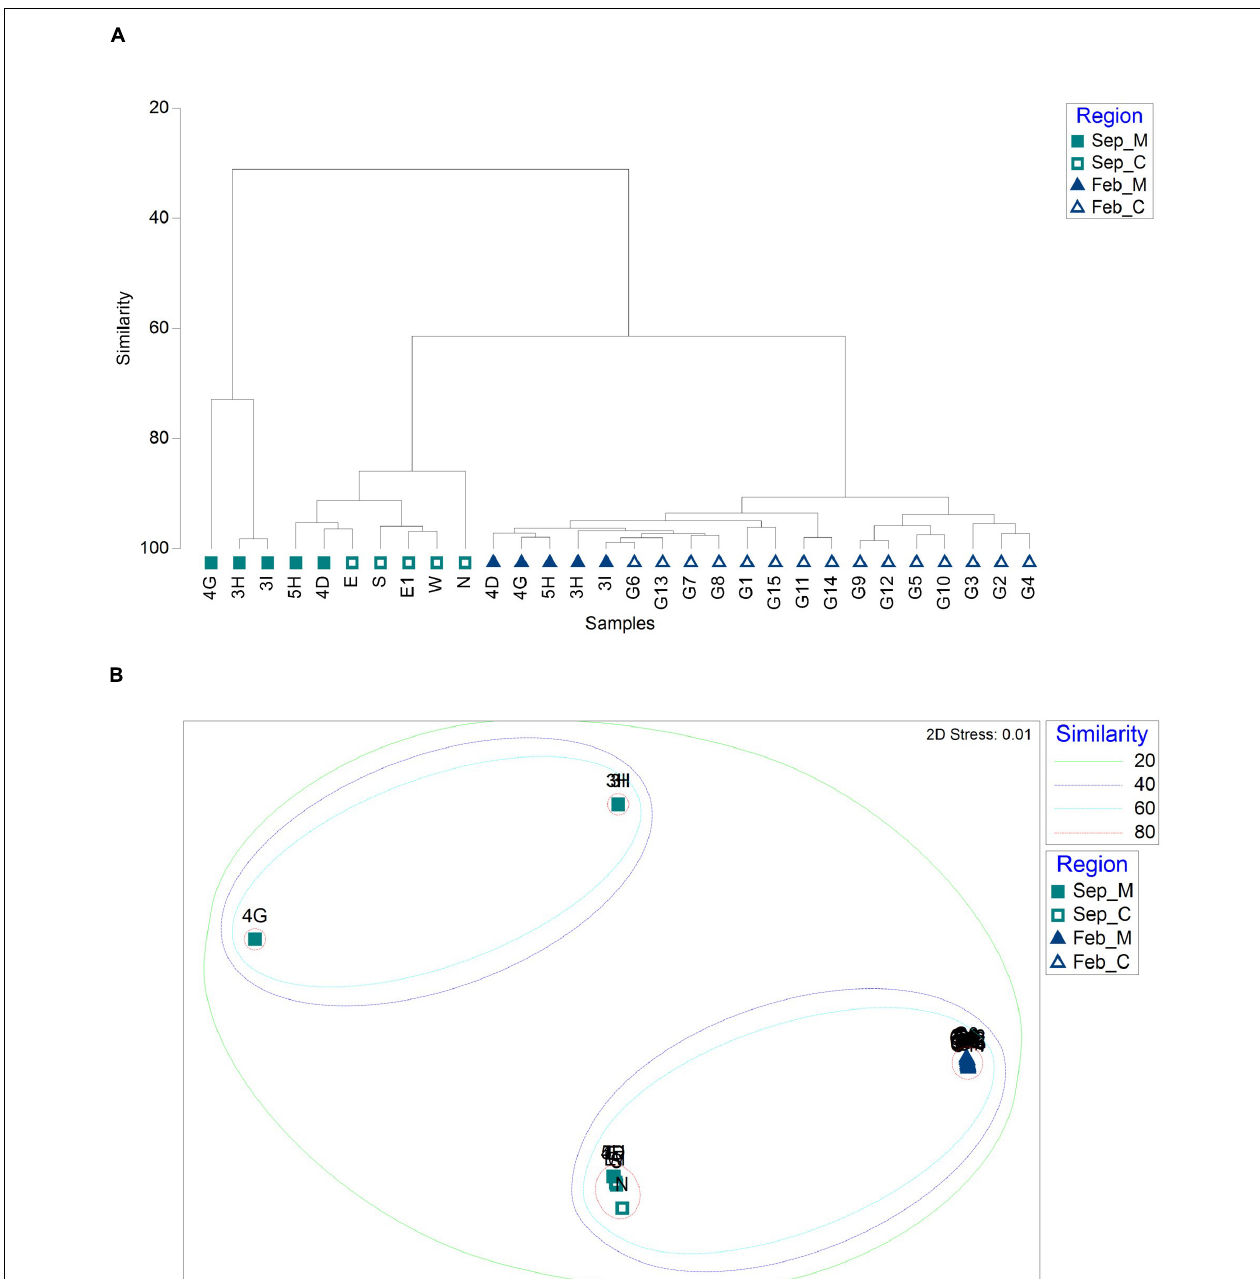
FIGURE 6 | Similarity analysis of phytoplankton communities between sample collection sites based on Bray–Curtis dissimilarity [ (A) dendrogram; (B) non-metric multidimensional scaling (NMDS) plot; and M and C in the legend represent aggregate mining and control regions,